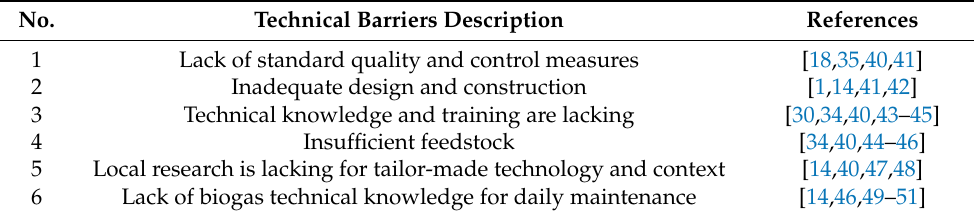
Table 1. Technical barriers for biogas